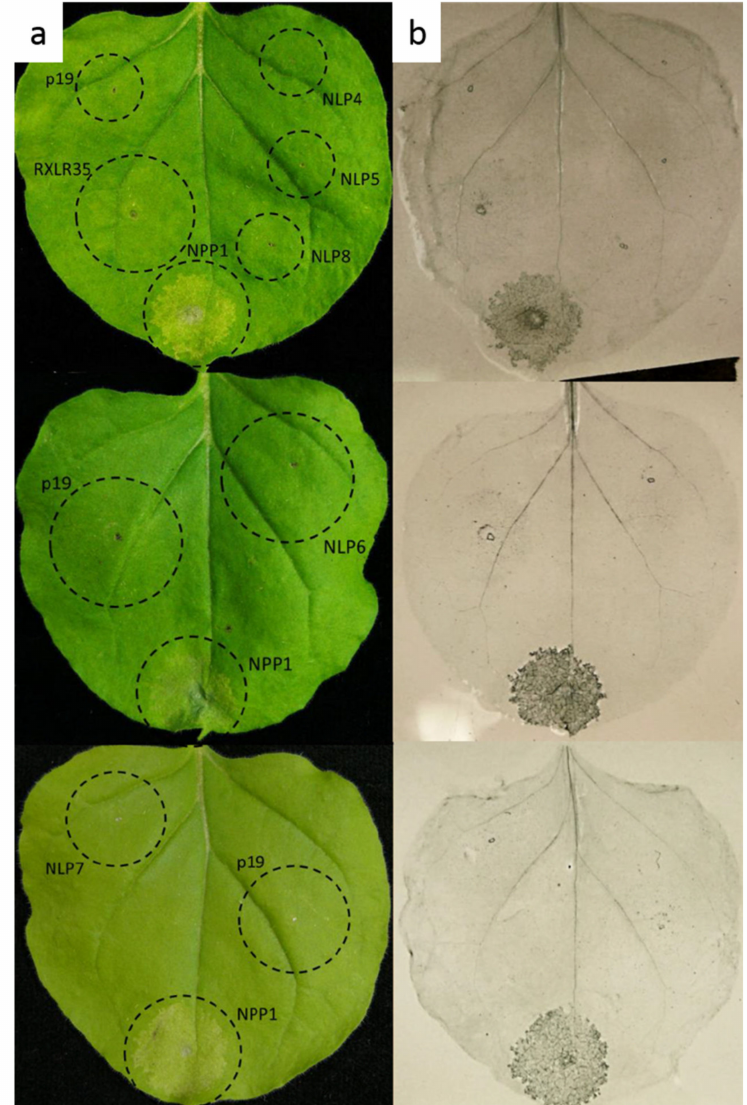
Figure 2. PvNLP are not able to induce necrosis in N. benthamiana : ( a ) Transient expression of NLP in leaves of N. benthamiana ; ( b ) Trypan Blue staining for cell death. All pictures were taken 72 h post infiltration. (p19 = silencing suppressor; NPP1 = Pi NPP1.1; RXLR35 = Pv RXLR35, NLP (4–8) = PvNLP